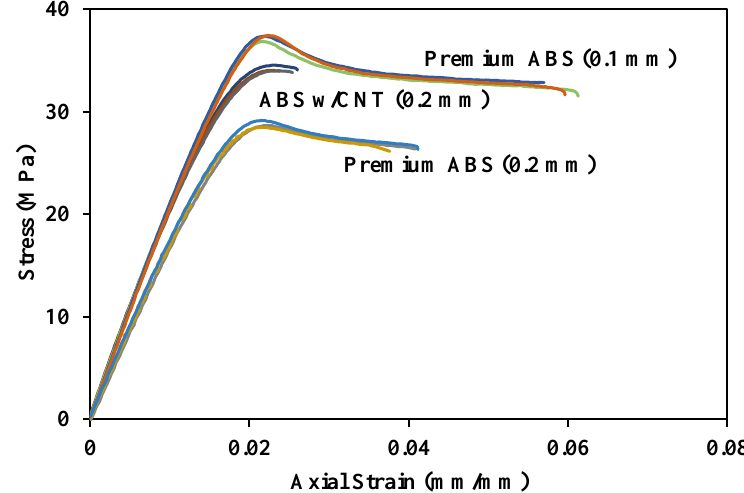
Figure 18. Tensile response of Premium ABS and ABS w/CNT printed at a 0.2 mm layer height.